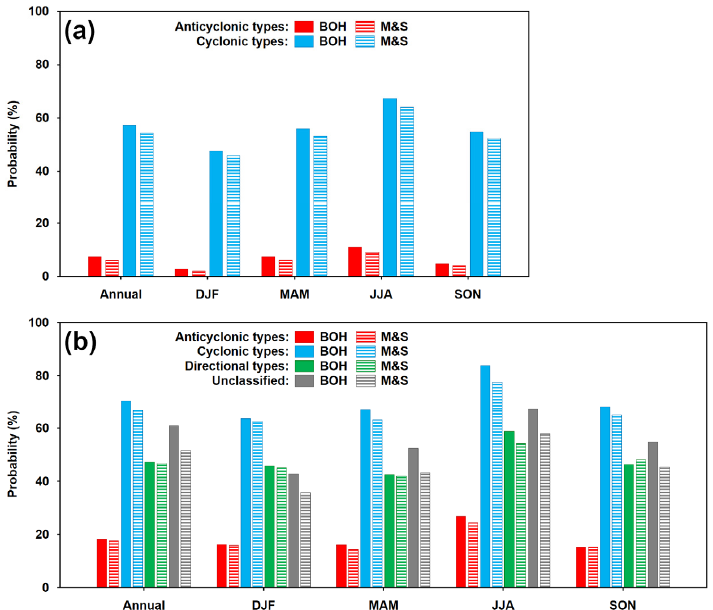
Figure 9. Annual and seasonal (DJF: December–February; MAM: March–May; JJA: June–August; and SON: September–November) probabilities of days with precipitation totals ≥ 1.0 mm for the groups of circulation types under the CHMI ( a ) and objective ( b ) classifications in Bohemia (BOH) and Moravia and Silesia (M&S) during the 1961–2020